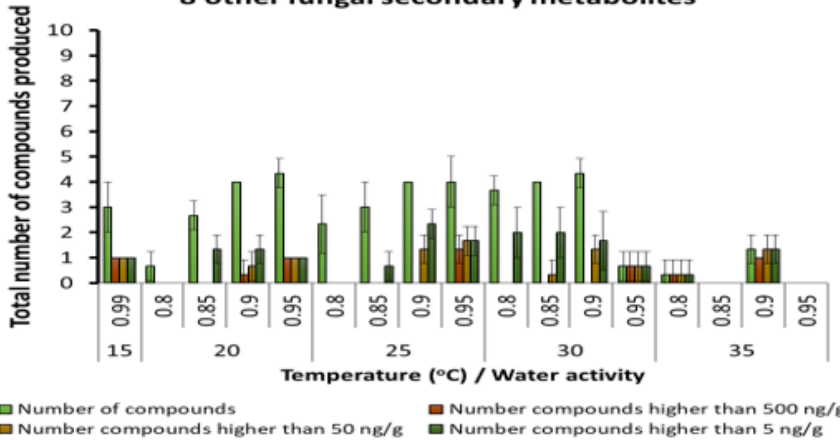
Figure 6. Other fungal metabolites detected in maize stored under different abiotic conditions. Bars represent the Standard Error of the mean. Note change in scale to 0–10 compounds.